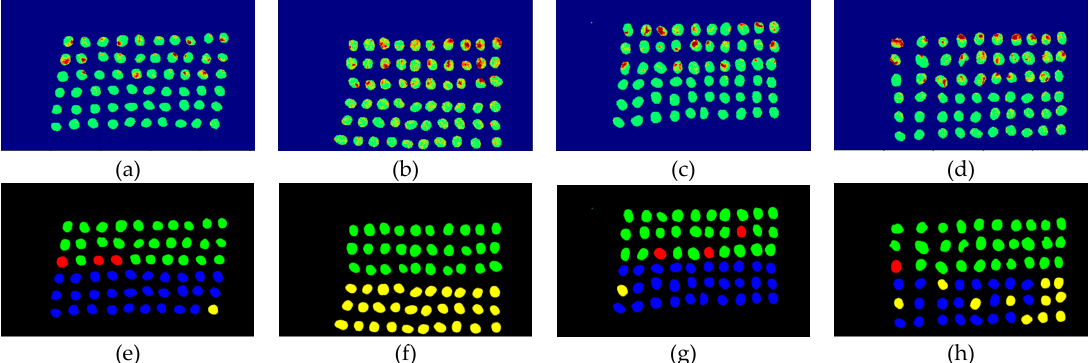
Figure 40. Results of green coffee bean CEM-SVM+MaxV_BP 20 bands. ( a-d ) SVM classification results, ( e-h ) final visual images. Remote Sens. 2018 , 9 , x FOR PEER REVIEW